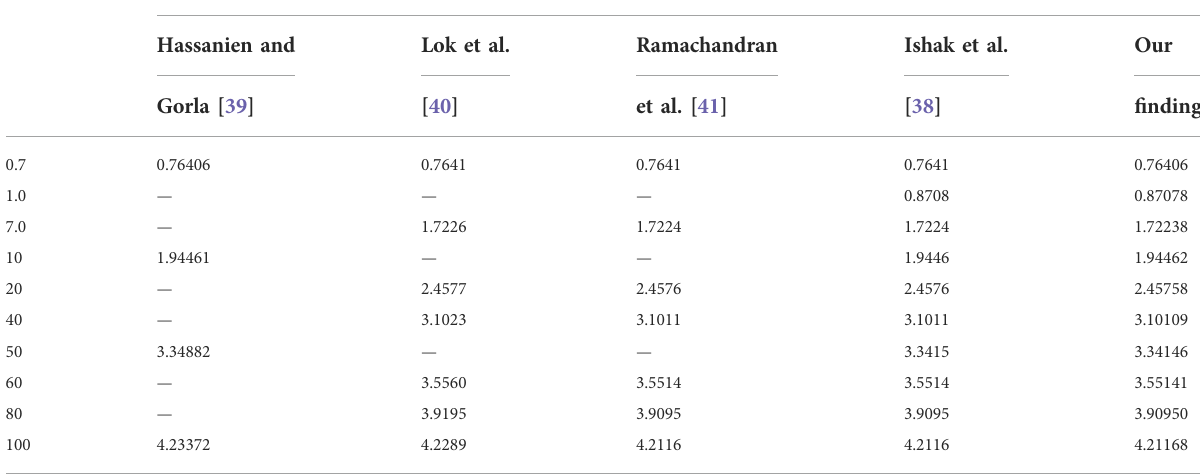
TABLE 2 Numerical evaluations for − Θ 9 (0) with fl uctuation in Pr . Pr